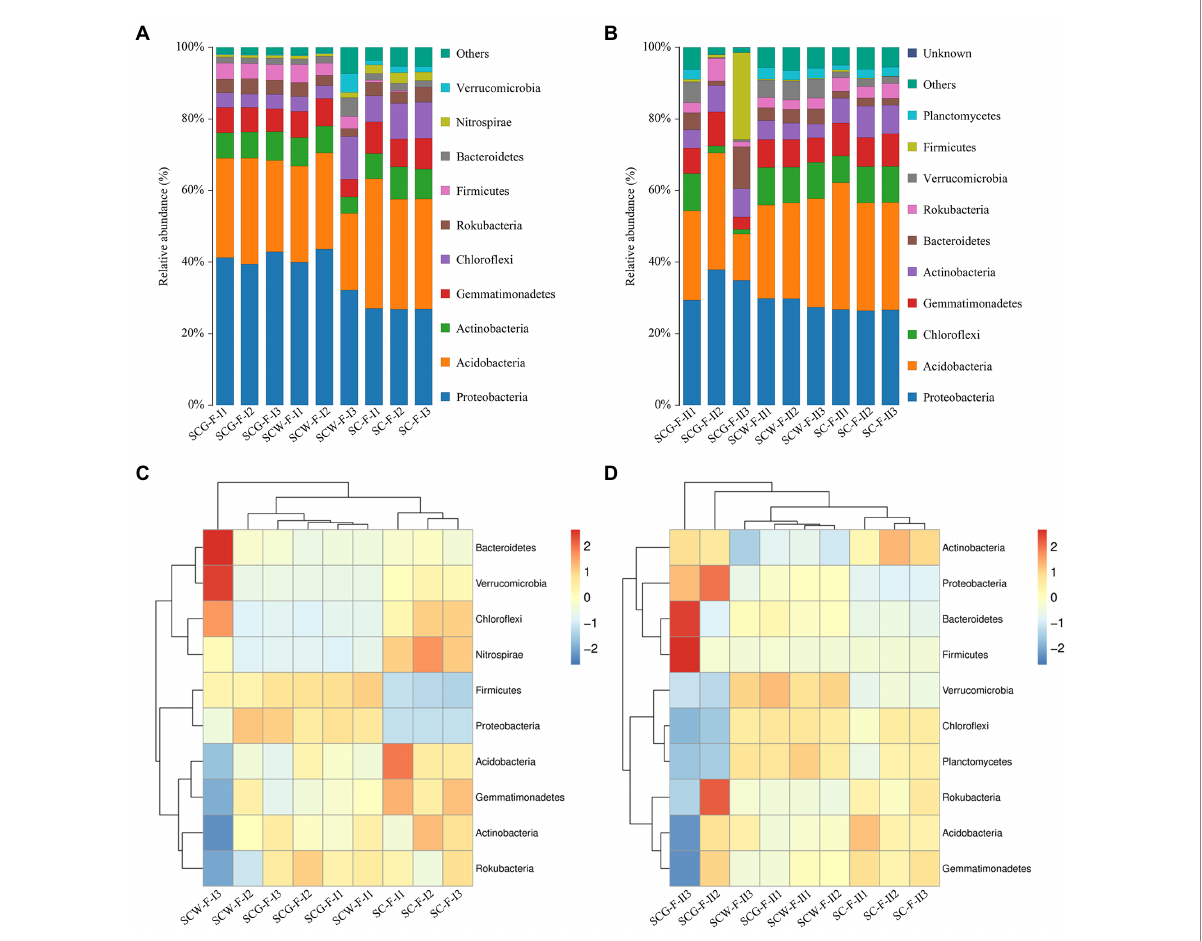
FIGURE 6 Taxonomic classification and relative abundance of bacterial communities at phylum level: (A,C) sampled after 11 weeks cultivation; (B,D) sampled after 17 weeks